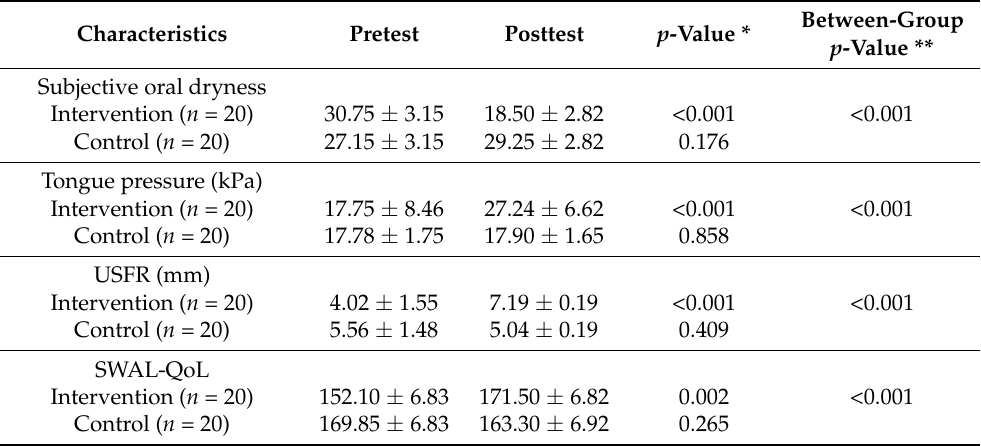
Table 4. Comparison of oral health and swallowing-related quality of life between the intervention and control